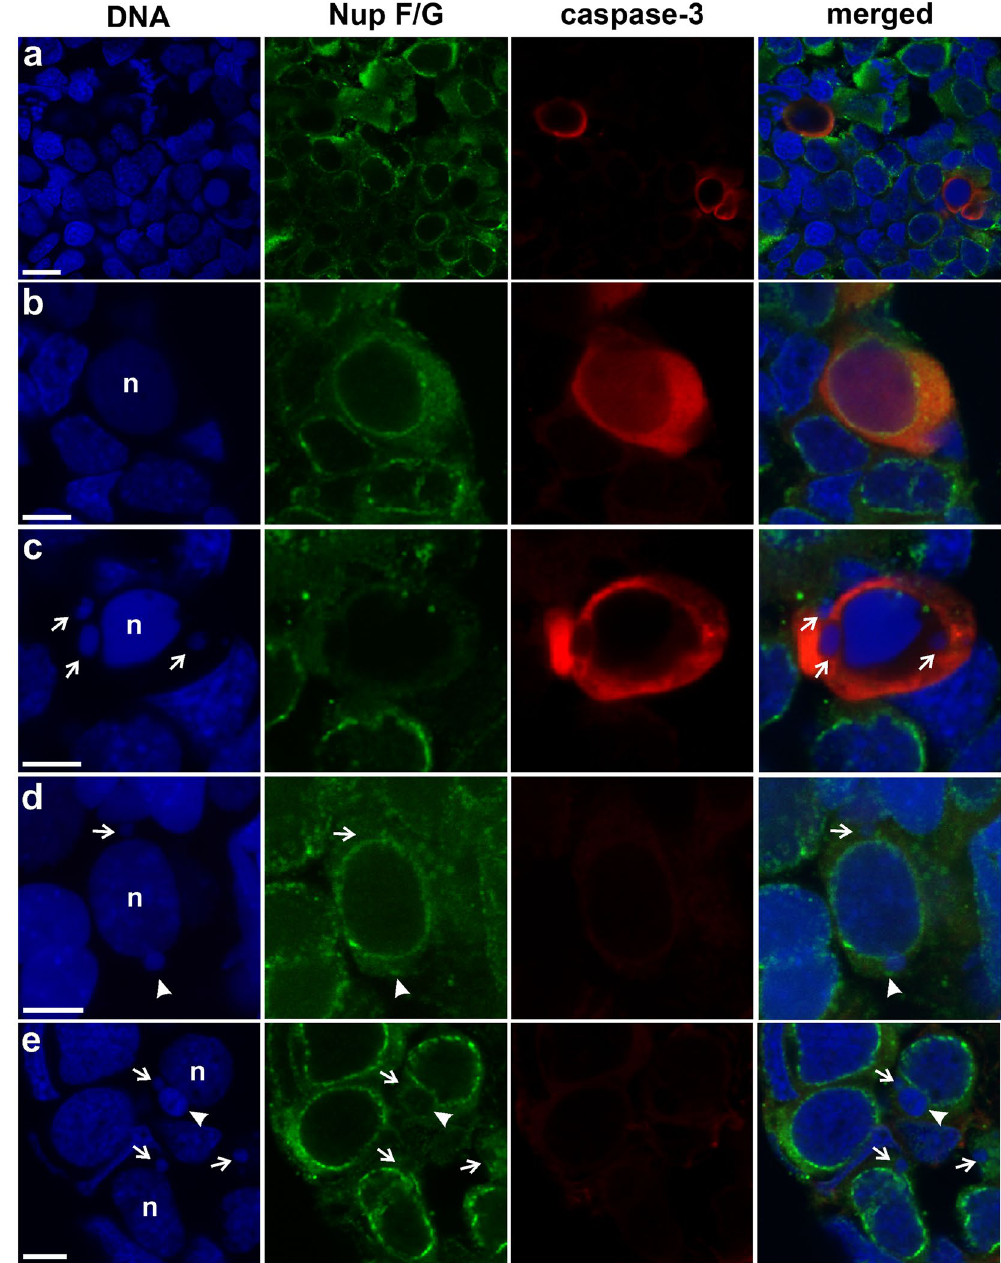
Figure 9. Presence of micronuclei does not lead to apoptotic death of gonocytes. Immunofluorescent staining of frozen tissue sections of gonads from P. esculentus diploid female ( a – c , e ) and male ( d ) at 34 Gosner stage: active caspase-3 (red), NPC proteins (Nup F/G, green), DNA counterstained with DAPI (blue). Gonocytes with positive expression of active caspase-3 showing various stages of degeneration: ( a ) the view of ovary section with interphase, mitotic and apoptotic germ cells, ( b ) germ cells possessing NPC proteins at the NE of nucleus containing flat/amorphous chromatin without heterochromatin/euchromatin structure and similar DNA condensation level as surrounding germ cells, may reflect the early stage of apoptosis ( c ) germ cell with pycnotic nucleus and three micronuclei completely devoid of NPC proteins (arrows) showing later stage of apoptosis. Apoptotic cells possessing micronuclei were very rare in gonads. ( d,e ) Majority of germ cells possessing micronuclei of various sizes and NPC proteins level represent the normal cellular morphology and absence of active caspase-3 apoptotic marker, suggesting that DNA elimination in micronuclei does not affect normal cellular processes. ( d ) Micronucleus with condensed chromatin decorated by NPC proteins dots (arrowhead), second micronucleus is lacking NPC proteins, ( e ) big micronucleus with highly condensed chromatin and weak NPC proteins signal at the nuclear membrane (arrowhead) and small micronuclei lacking NPC proteins signal (arrows). Confocal images represent single z-section ( a–c,e ) or projection of 12 z-sections ( d ) (0.46 µ m) to image micronuclei at different levels in the cell. Scale bars ( a ) 10 µ m, ( b – e ) 5 µ